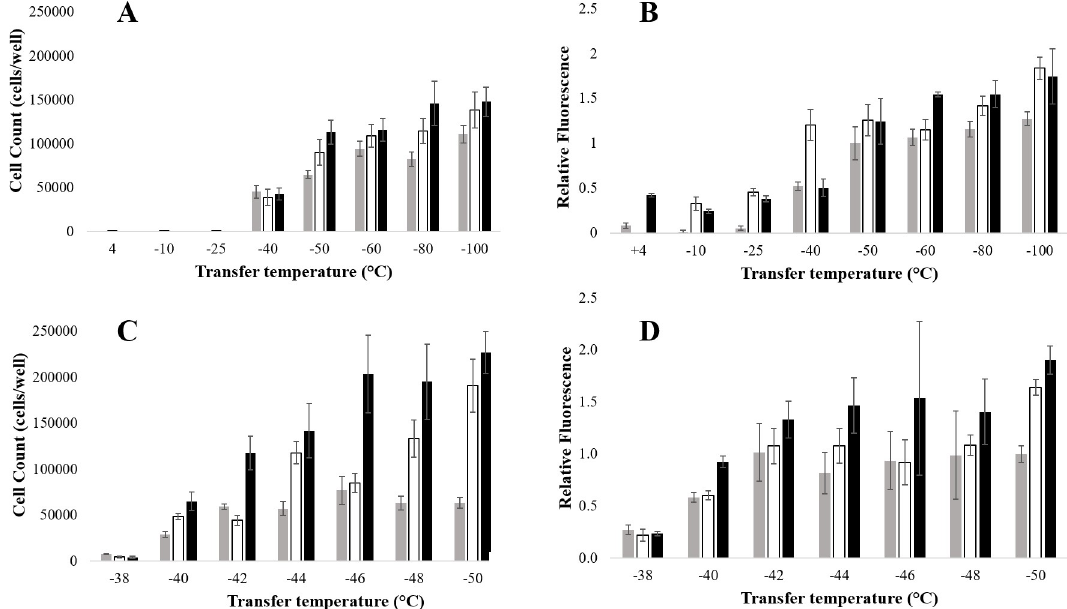
Fig 4. Viable cell count (A, C), and metabolic activity (B, D) of Jurkat cells cooled down at 1˚C min -1 to separate endpoints before plunging into liquid nitrogen. Viable cell count was measured through fluorescein diacetate staining and metabolic activity was evaluated through the reduction of resazurin to the fluorescent resorufin, at 24 h (grey), 48 h (white), and 72 h (black), post thaw (n = 5 ± SD). For metabolic activity, fluorescent intensities were normalised to 1 at the -50˚C, 24 h time point.